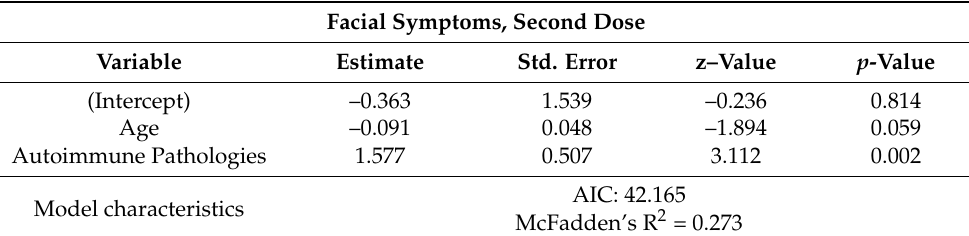
Table 7. Logistic model results for facial symptoms occurrence after second